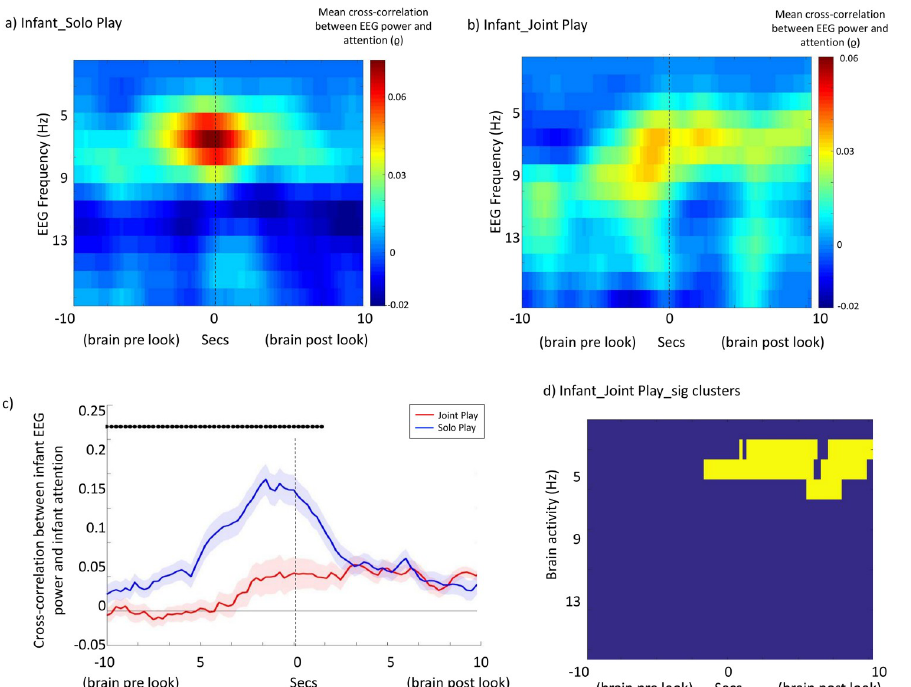
Fig 3. Brain–behaviour associations: Infant solo play and joint play. (a and b) Mean time-lagged cross-correlations between EEG power and visual attention for (a) infant solo play and (b) infant joint play. (Fig 3A is identical to Fig 2A but included to allow for comparison with Fig 3B). (c) Line plot showing cross-correlation between EEG power and visual attention for just the frequency ranges identified from the cluster-based permutation test as showing marked effects in both conditions (3 Hz–6 Hz). Red shows the joint play condition, and blue the solo play condition. Shaded areas show interparticipant variance (standard errors). Dots above the plots indicate the results of the significance calculations to assess whether the correlations observed differed significantly between the two conditions. (d) Results of the cluster-based permutation statistic for infant joint play. Yellow squares indicate time × frequency points of significant cross-correlations. The underlying data for this figure can be found in S1 Text and S1